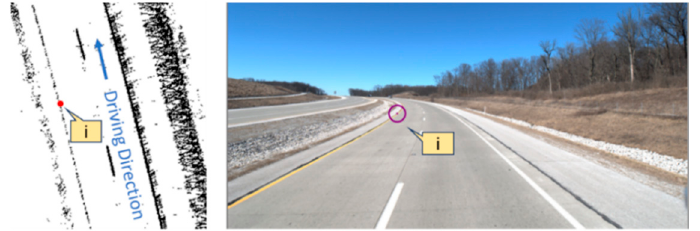
Figure 13. Illustrations of hypothesized lane markings (extracted by a fifth percentile intensity threshold) and corresponding RGB imagery.